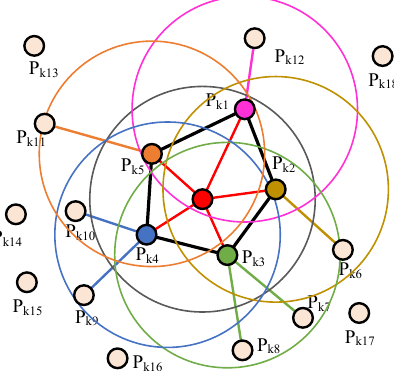
Figure 7. Schematic diagram of the affected area of FPFH.